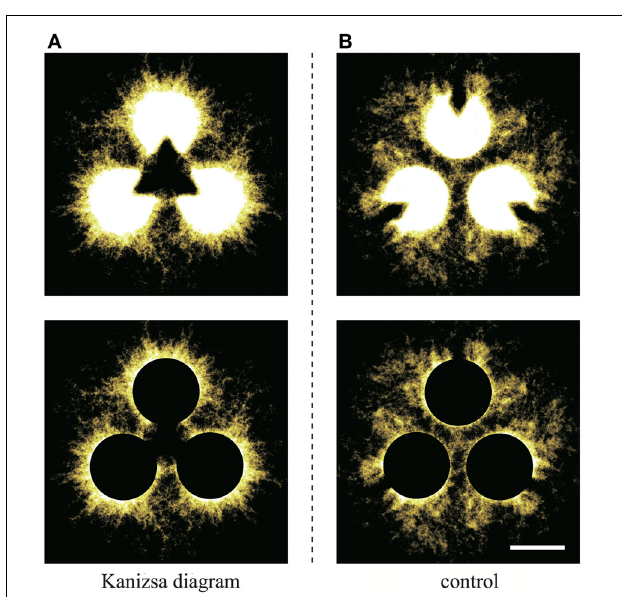
FIGURE 9 | The upper diagrams are produced by stacking binaralized images of the plasmodial networks for all trials. (A) Kanizsa diagram and (B) control. The brightness of each site indicates the intensity of lapping; that is the existence probability of the plasmodium at the site. A filter that cuts-off the weak signals was applied to improve visibility. This threshold is common to both figures. In the lower diagrams, to wipe out the effect of Kanizsa illusory contour, the pac-men are covered by black (scale bar: 10mm).